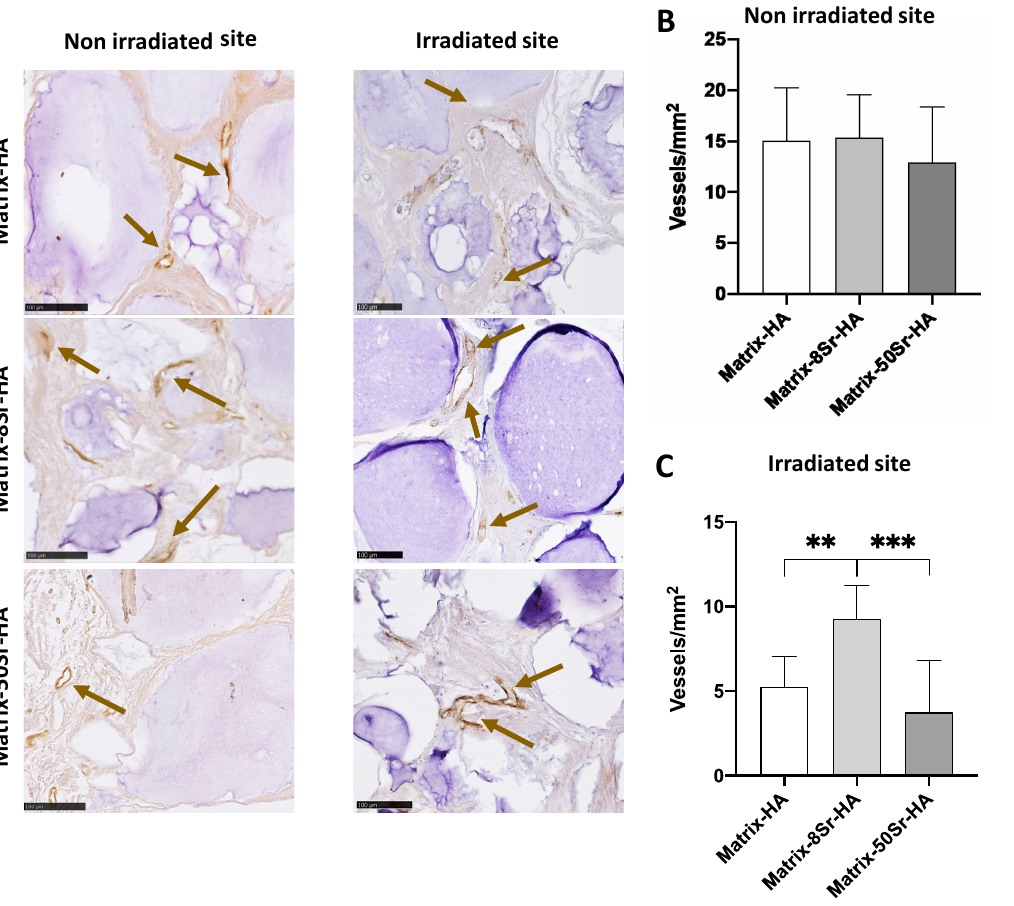
Figure 8. Immunohistochemistry of vWf in the newly formed tissue within the Matrix-HA groups supplemented or not with strontium after radiation procedure: ( A ) vWF immunostaining of the newly formed tissue within the three groups of matrices (Matrix-HA, Matrix-8Sr-HA, and Matrix-50Sr-HA) without or after irradiation procedure (non-irradiated versus irradiated site) after 12 weeks of implantation. Scale bar on the left and right panel: 100 µm. ( B , C ) Quantification of the number of vessels within the tissue was performed. Results were expressed as average ± SD per group of microbeads (Matrix-HA, Matrix-8Sr-HA, and Matrix-50Sr-HA) for both conditions: ( B ) non-irradiated site versus ( C ) irradiated site. The symbols ** and *** denote p < 0.01 and p < 0.001, respectively. The brown arrows indicate the staining of the vessels.